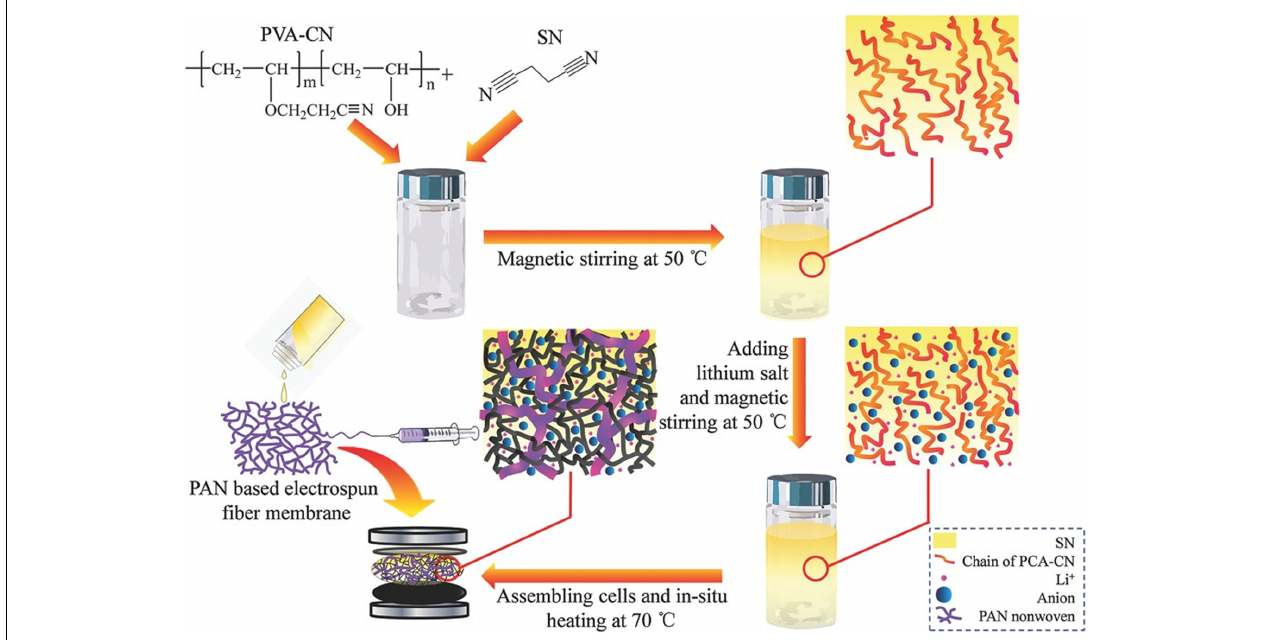
FIGURE 6 | Schematic image showing the procedure for the in situ synthesis of solid-state electrolyte based on nitrile materials. Reference Zhou et al. (2015). Copyright 2015 John Wiley and Sons.